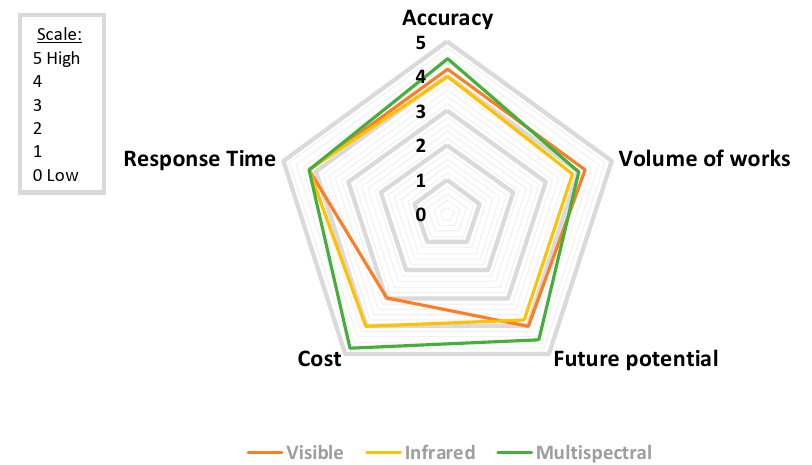
Figure 4. Radar chart showcasing the findings of this review for different sensor types with regards to accuracy, response time, cost, future potential, and volume of works in the scale 0 (low) to 5